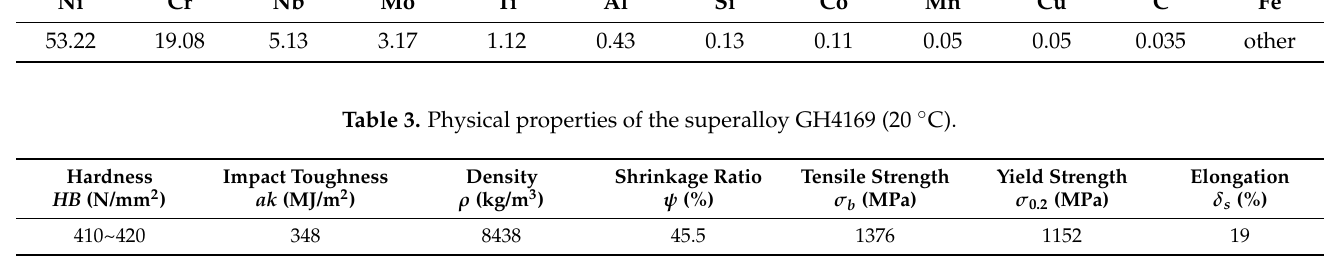
Table 2. Chemical composition of the superalloy GH4169 (mass fraction, %).